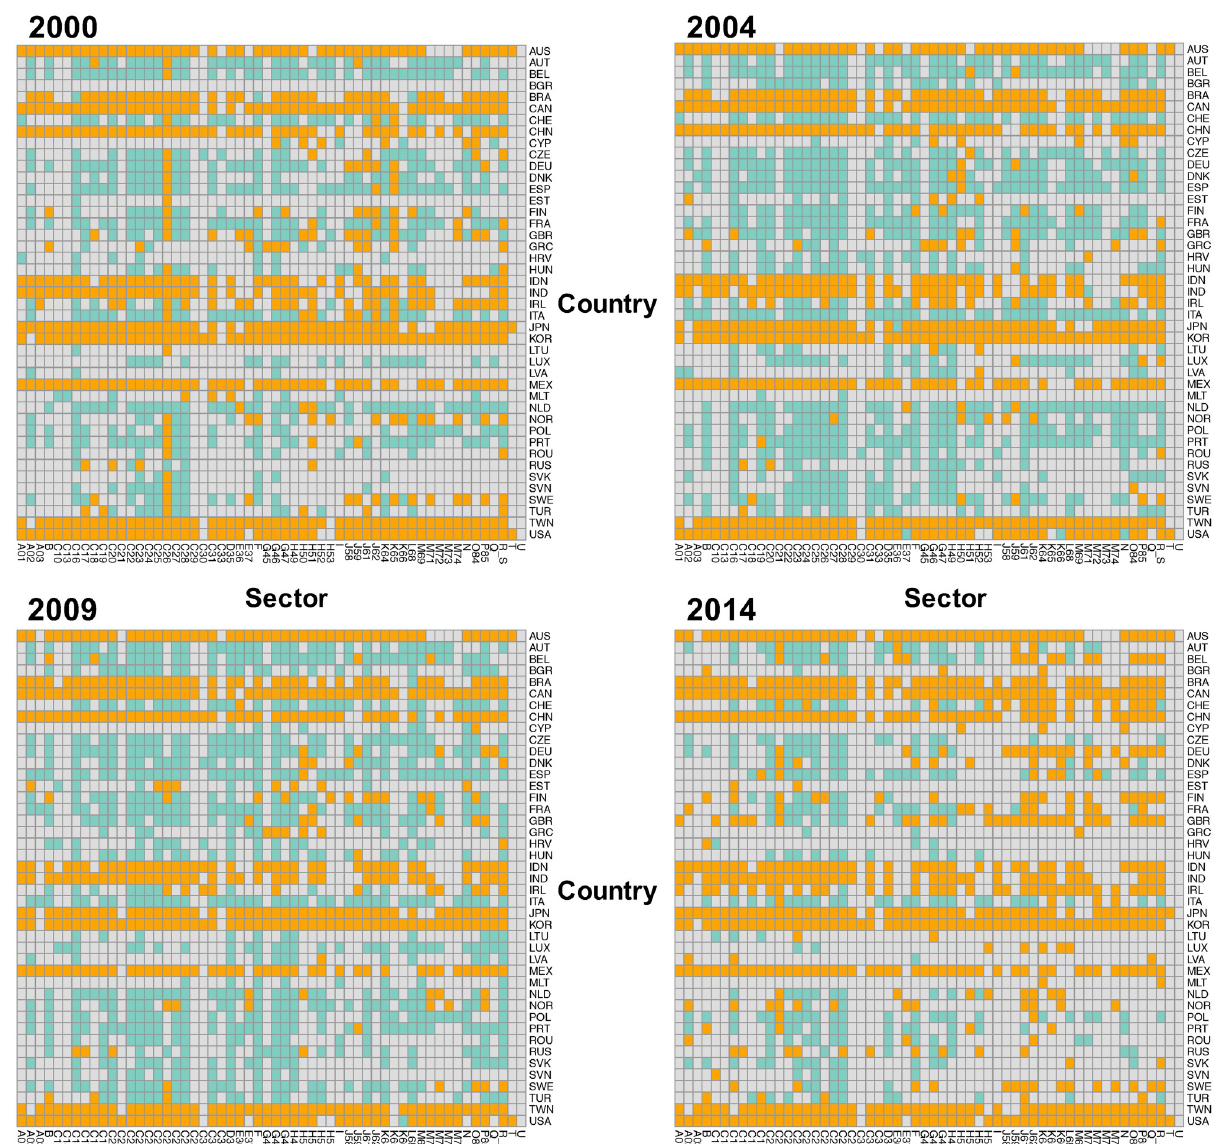
Fig 2. Community maps in 2000, 2004, 2009, and 2014. Each cell is a node of IVAN, the gray cells are the nodes that do not belong to any of two communities, while the other colors indicate community. The green ones belong to the community dominated by sectors of European countries and the orange ones to the community dominated by sectors of the Pacific Rim countries. The regional classification is in S1